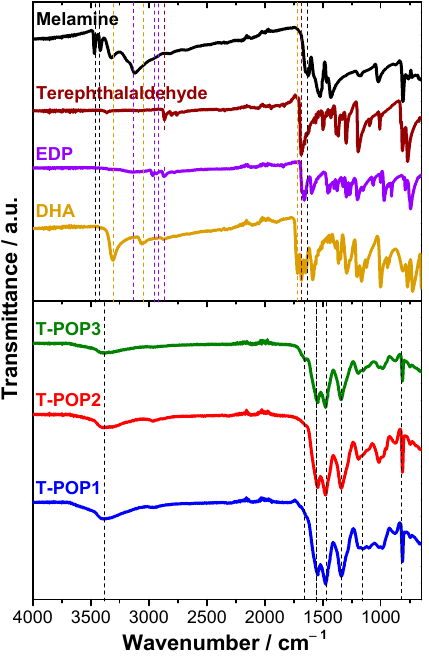
Figure 2. FTIR spectra of monomers (melamine, terephthalaldehyde, 4-ethyl-2,6-diformylphenol (EDP), 3,5-diformyl-4-hydroxybenzoic acid (DHA)) and polymers (T-POP1, T-POP2, T-POP3). Despite formyl group vibration bands, EDP for T-POP2 synthesis also presents peaks